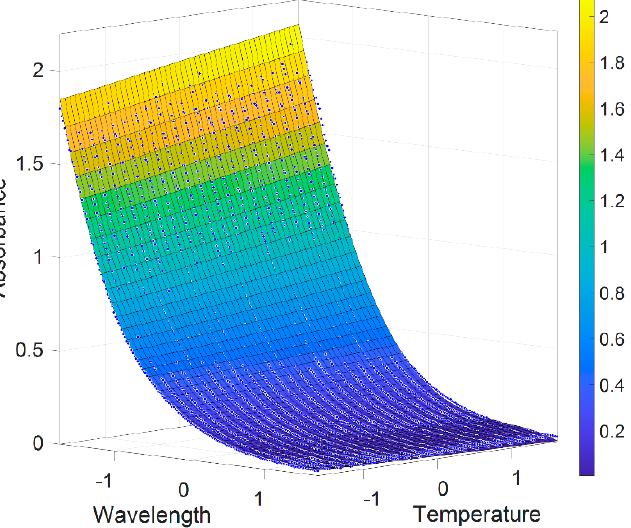
Figure 6. Three-dimensional absorption model of low nutrient seawater (LNS). In order to obtain better LNS fitting model, temperature and wavelength are normalized by the equation t )( tmeant − )( wlmeanwl − wl − mean ( wl ) . and std ( wl ) )( tstd )( wlstd